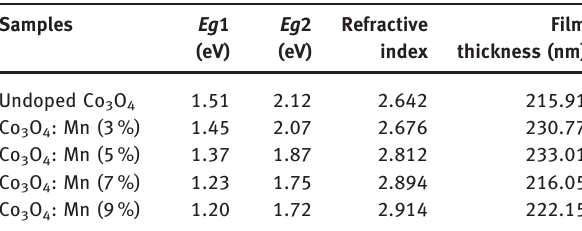
Table 1: Band gap energies, average of transmission, refractive index and film thickness of Mn-doped Co 3 O 4 films.